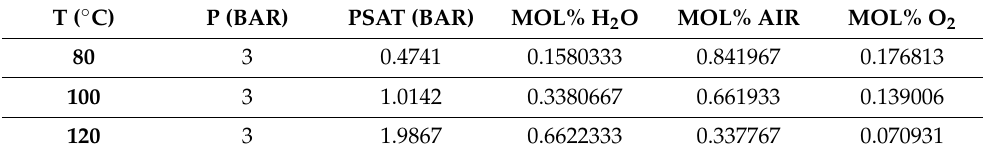
Table 8. Cathode oxygen content vs. temperature at 100% relative